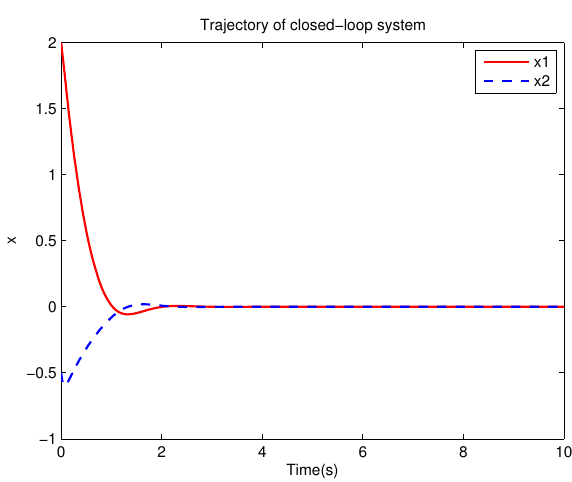
Figure 4. Closed loop system trajectory, p 1 = − 1, p 2 = 4.